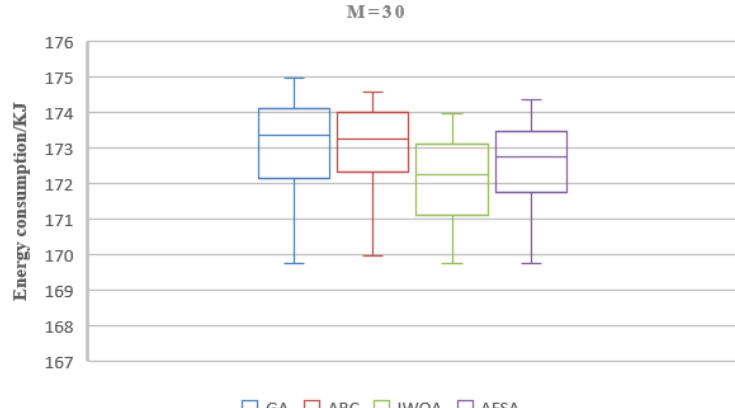
Figure 12. Running time box plot when the population is 5.